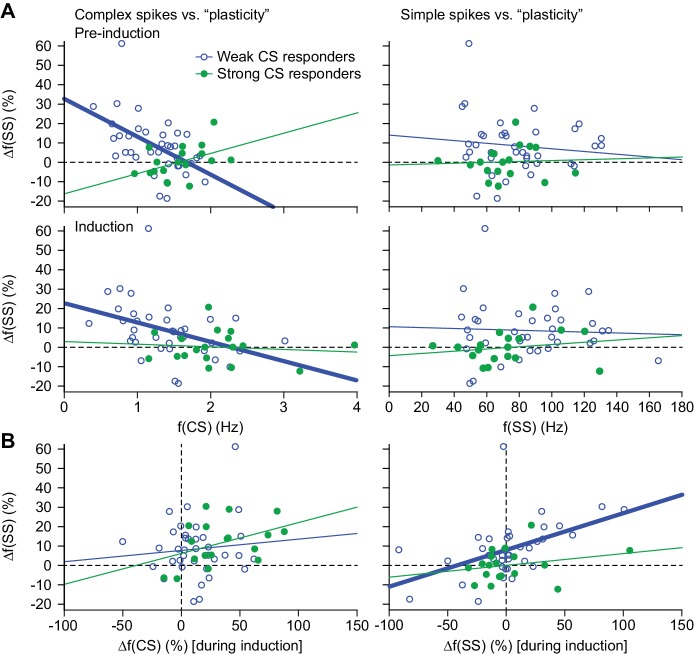
Complex spike rates are negatively correlated with sensory-induced potentiation.(A) Scatter plots with linear regression lines between complex spike (CS) (left) and simple spike (SS) frequency (right) during the pre-induction (top) and the induction (bottom) period with the percentage of change in simple spike response between post- and pre-induction. The complex spike firing rate was negatively correlated with the change in simple spike responses in those PCs that had weak complex spike responses (see Figure 2—figure supplement 1) – both during the pre-induction and during the induction interval. However, no such significant correlation was found in the strong complex spike responders. The simple spike rate did not have a significant correlation with simple spike responses. (B) In contrast to the absolute firing rate, the difference in complex spike firing during the pre-induction versus the induction block did not show a clear correlation with changes in simple spike responsivity (left). Increased simple spike firing during the induction block, however, correlated well with increased sensory simple spike responses during the post-induction block. Thick lines indicate significant linear correlations (p<0.002).